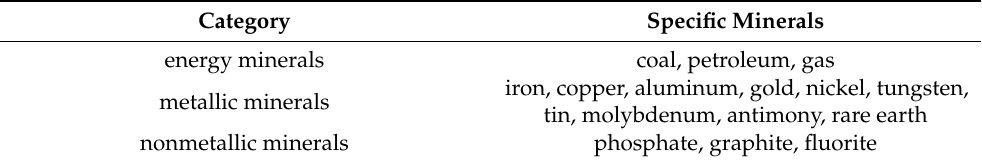
Table 1. Research